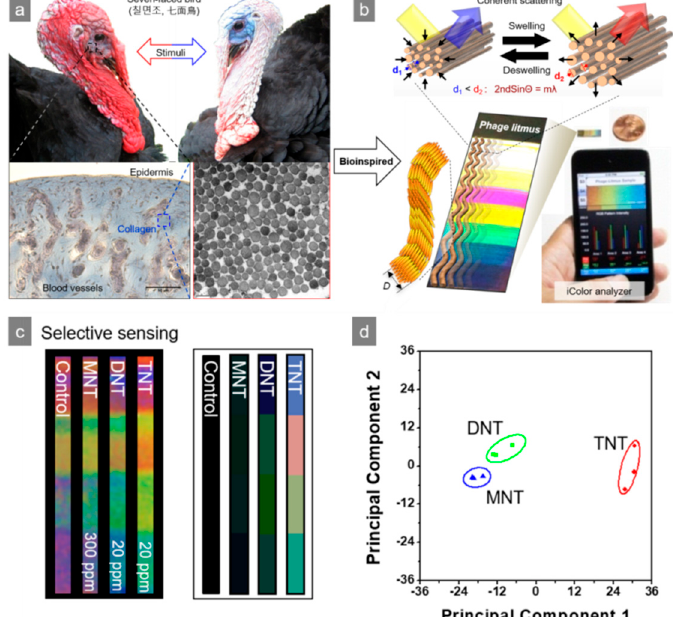
Figure 2. Nitrotoluene derivative detection using a M13 bacteriophage-based color sensor. ( a ) Bio-mimic structure of turkey collagen, ( b ) reversible color responding of a color sensor, ( c ) sensitivity of M13 bacteriophage-based color sensor upon exposure to nitrotoluene derivatives, and ( d ) principal component analysis (PCA) plot of the color changes. Reproduced from [4], with permission from Springer Nature, 2014.